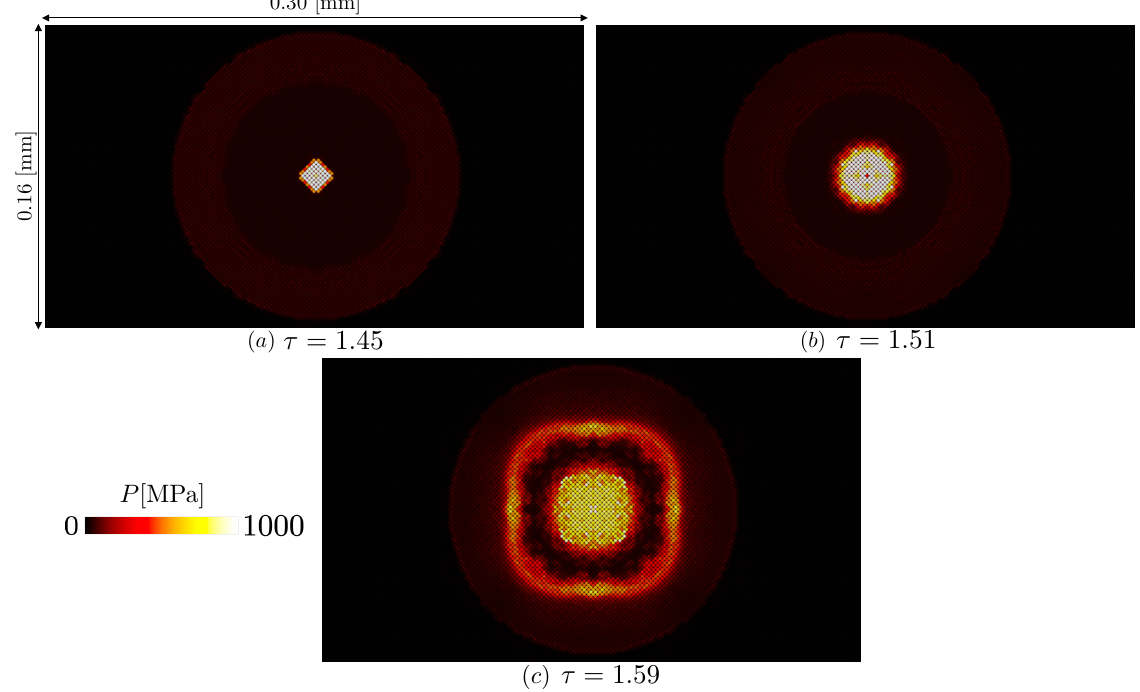
Figure 6. Pressure field over the surface for different collapse snapshots in Region II ( dL / R 0 = 133, γ = 0.6 & P ∞ = 50 [MPa]): ( a ) Pressure field of the surface during the water hammer impact between the surface and the jet. ( b ) Pressure field of the surface during the jet split. ( c ) Pressure field of the surface at the impact between the lateral jet and the cavity